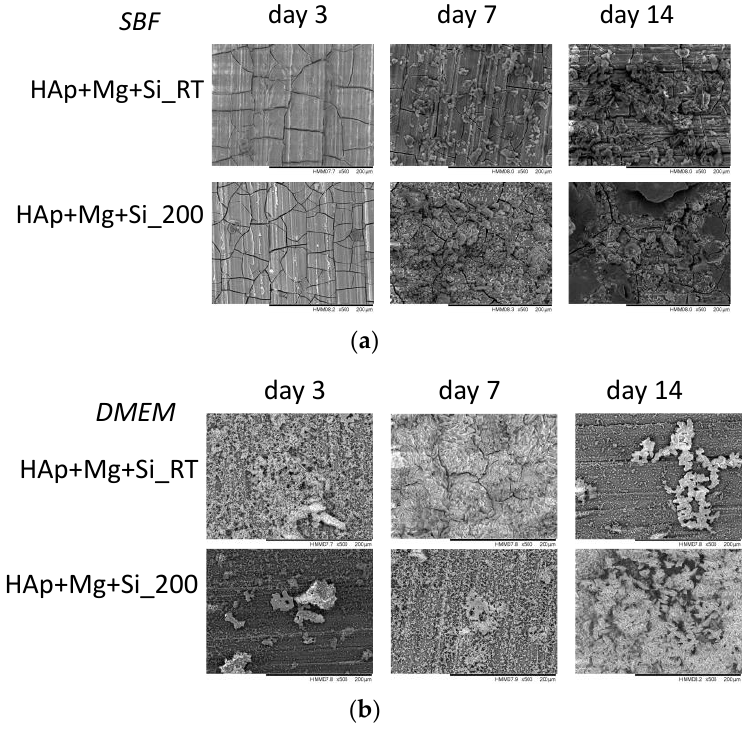
Figure 9. SEM images of degradation of surfaces after ( a ) Tests in SBF solution; ( b ) Tests in DMEM solutions.